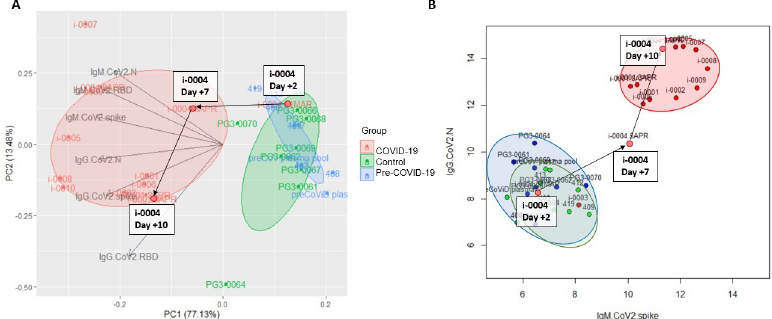
Fig 5. Combining IgG and IgM responses to distinguish COVID-19 samples. PCA plot of IgM and IgG responses to SARS-CoV-2 antigens spike, RBD, NTD, and Ncap (A) for COVID-19 (red), Control (green), and pre-COVID (blue) subjects. Loading vectors showing the direction of the contribution of each parameter to the PCA are shown. Ellipses correspond to 50% confidence intervals for each group. Scatterplot of IgM SARS-CoV-2 spike responses and IgG SARS-CoV-2 Ncap responses for all three groups. Longitudinal data for COVID-19 subject i-0004 collected on Day +2, Day +7, and Day +10, relative to day of initial test positivity, is highlighted as the subject seroconverted over this time